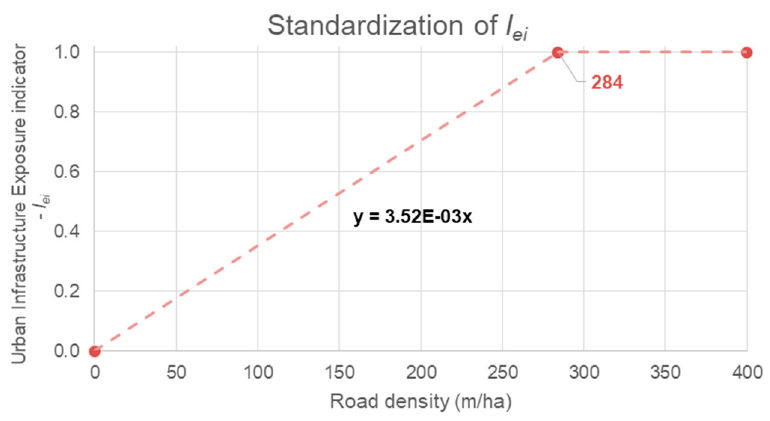
Figure 2. Standardization of the Urban Infrastructure Exposure indicator (I ie ).